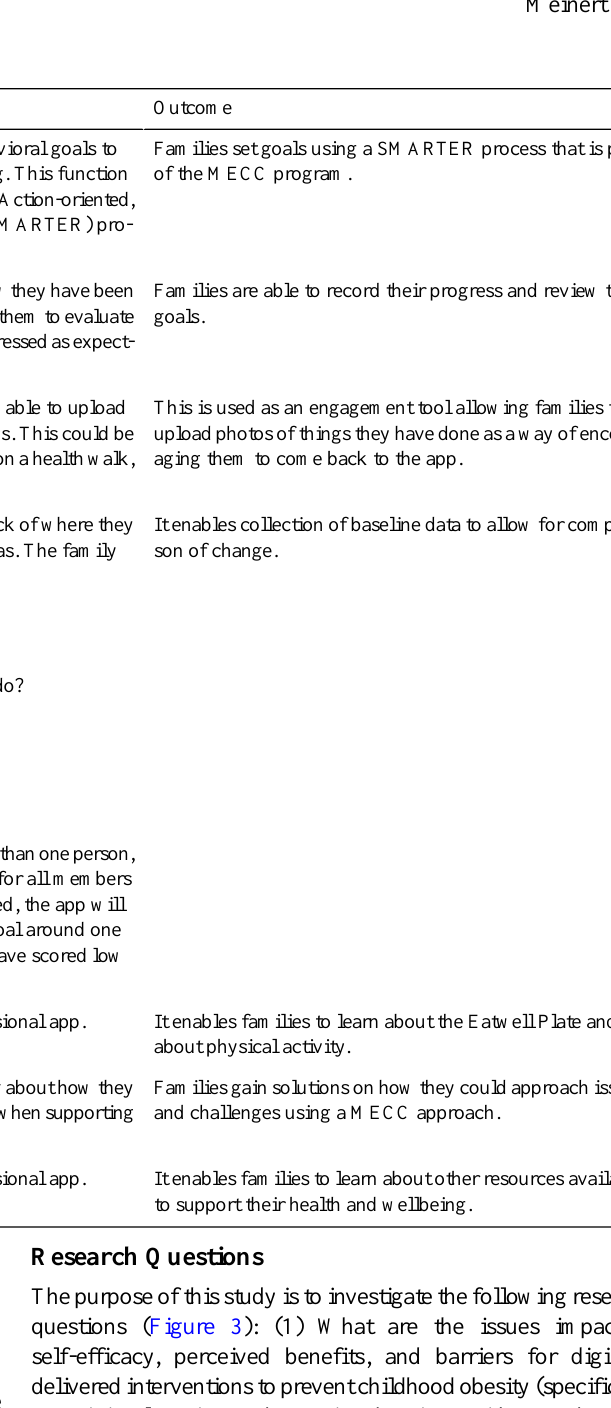
Families set goals using a SMARTER process that is